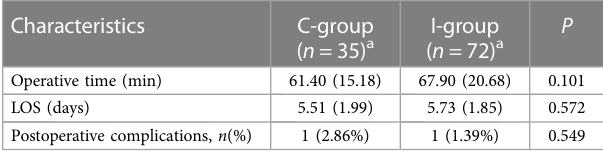
TABLE 4 Outcomes of interval appendectomy after conservative treatment for the control group and intervention group.